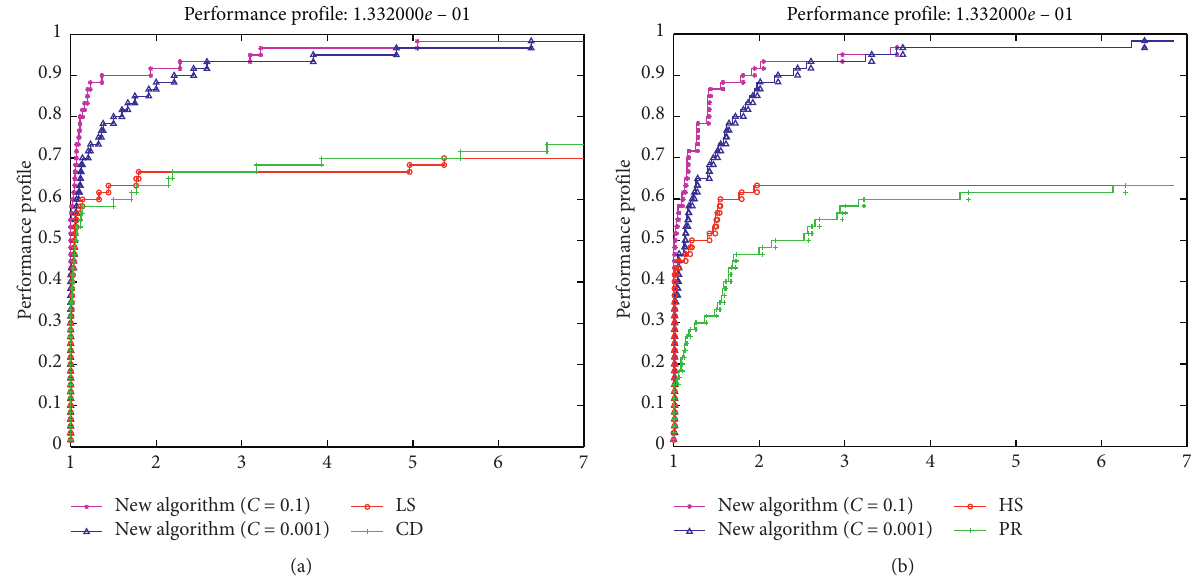
Figure 2: Performance profiles based on function and gradient evaluations (NOFG). (a) Comparison of the new algorithm vs. LS and CD. (b) Comparison of the new algorithm vs. HS and